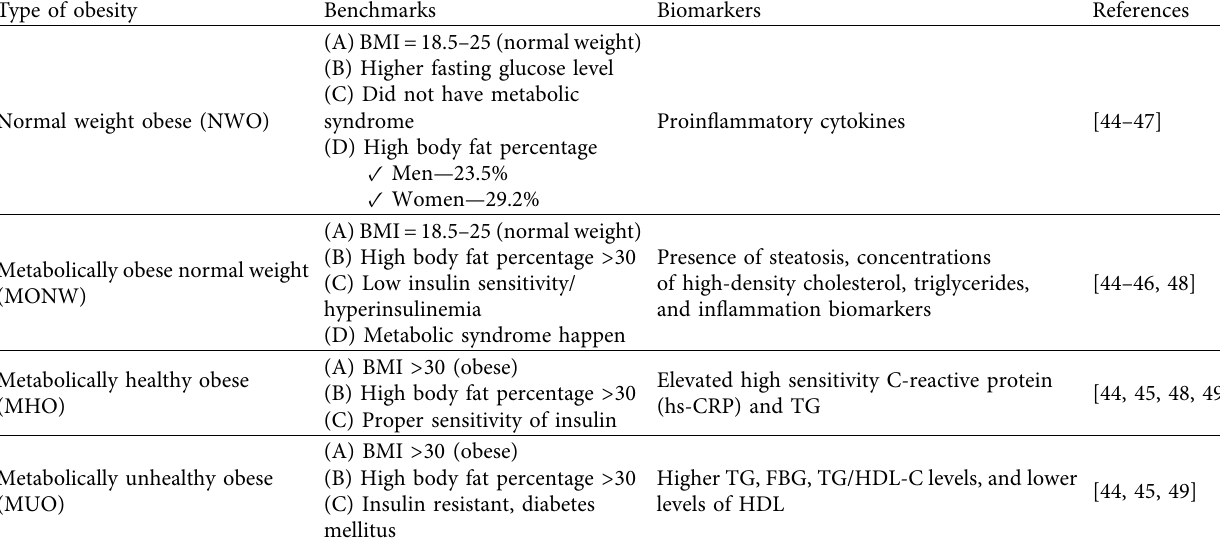
Table 2: Phenotype of obesity and its